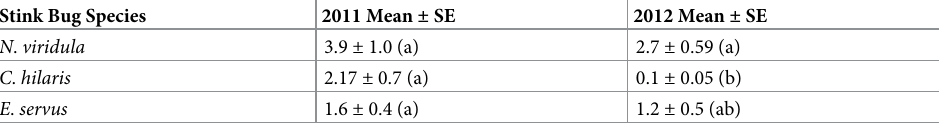
Table 4. Mean stink bugs collected by 100 sweeps by sweep net across the season. Means followed by the same low- ercase letter are not significantly